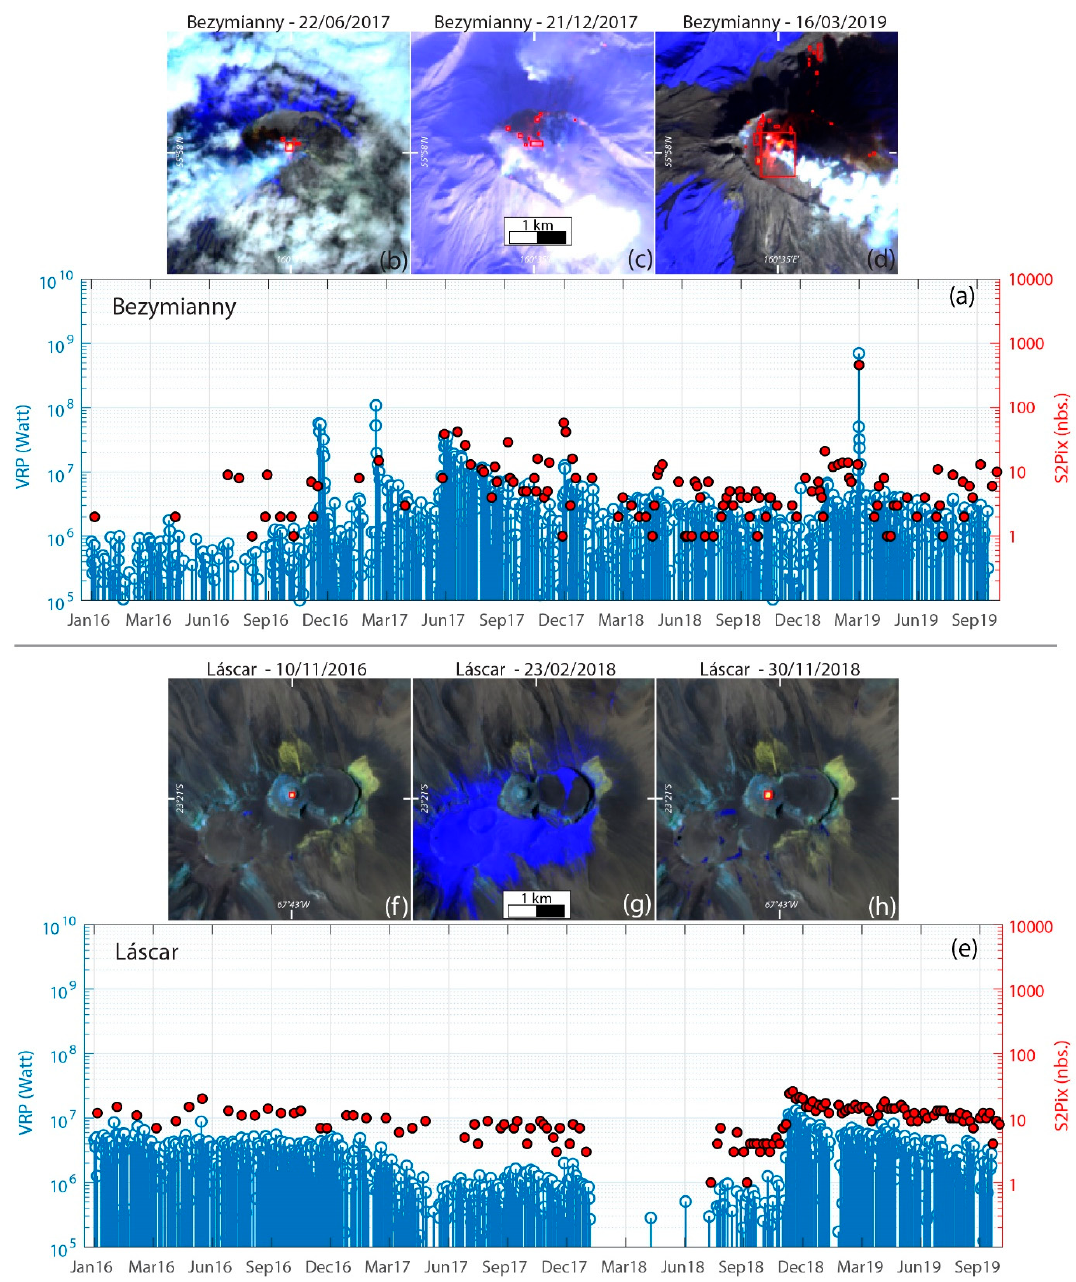
Figure 11. S2Pix and VRP–MIROVA thermal comparison on Bezymianny and Láscar lava-dome-type case studies. In ( a , e ), y-logarithmic timeseries. With blue stem on left y-axis, MIROVA VRP heat flux in Watt; with red dots on right y-axis, the S2Pix. In ( b – d ), particulars of thermal emissions and lava dome activity over Bezymianny summit area. In ( f – h ), particulars of thermal emissions and dome activity of Láscar.